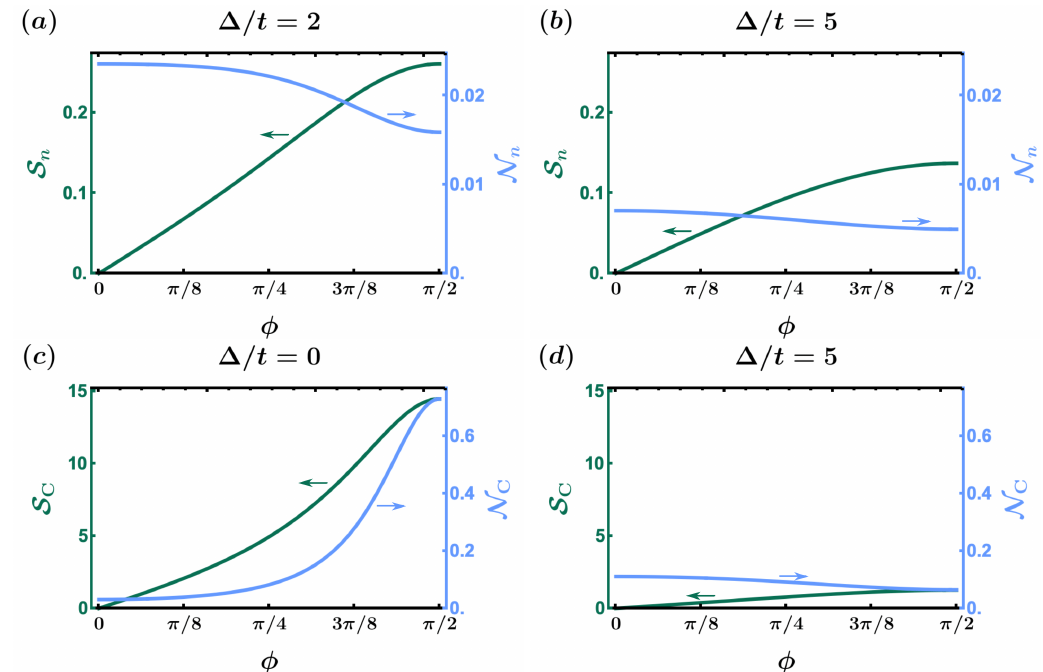
Figure 6: Signal (20) and noise (21) for the 2-MZM measurement of the average QD 〉 (a)-(b) and differential QD capacitance C charge 〈 n QD